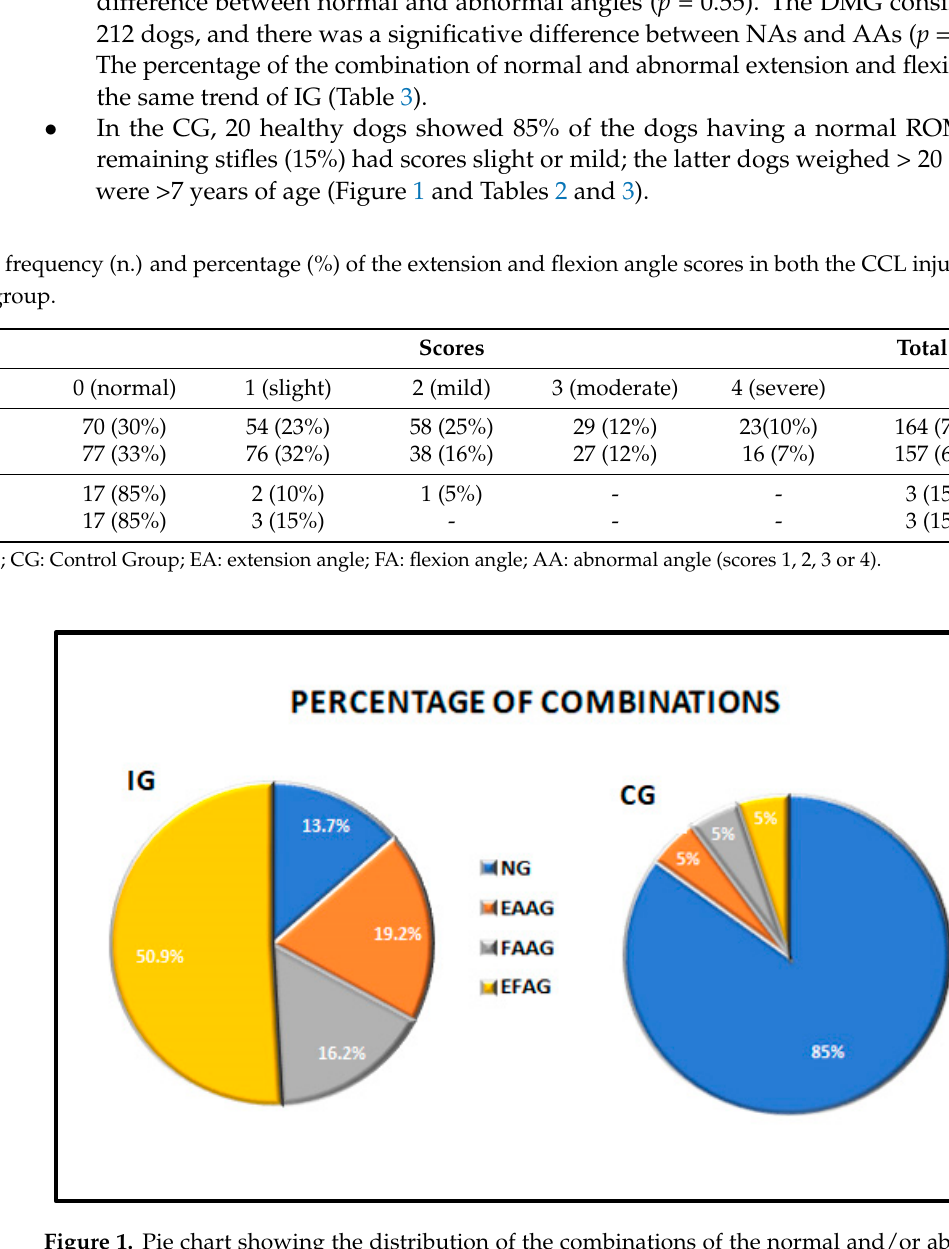
Figure 1. Pie chart showing the distribution of the combinations of the normal and/or abnormal angles of extension and flexion in the IG and the CG. IG: injury group; CG: control group; NG: normal group; EAAG: extension angle abnormal (reduced) group; FAAG: flexion angle abnormal (increased) group; EFAG: extension and flexion angle abnormal group. Table 3. Percentage of score combinations of the normal and abnormal angles in the various groups.